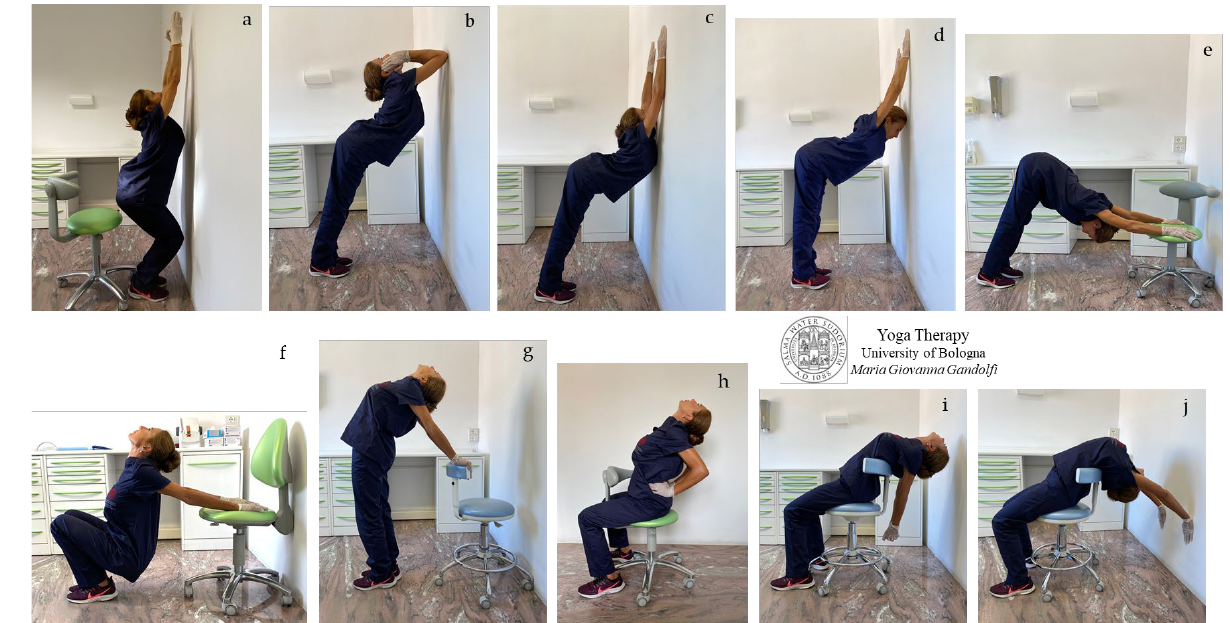
Figure 3. The figure displays the proposed āsana for neck and chest extension. Utkatāsana ( a ), Utthana/Sama Hasta Hanu Shishosana (standing puppy pose with hands on the chin) ( b ), Utthana/Sama Uttana Shishosana (standing extended puppy pose) ( c ), Utthana/Sama Adho Mukha Svanāsana (standing downward-facing dog) ( d ), Adho Mukha Svanāsana (downward-facing dog) ( e ), Upavistha Ardha Purvottanāsana (seated half-upward plank pose) ( f , i ), Anuvittāsana (variation of standing backbend pose) or Upavistha Sarpāsana or Salabhāsana (standing snake or locust pose) ( g ), Upavistha Anuvittāsana (seated backbend pose with palms pushing the sacrum) ( h ), and Upavistha Chakrāsana or Urdhva Dhanurāsana (seated full-wheel pose or upward bow pose) ( i , j ). It should be emphasized that the cervical muscles join and pull the cervical vertebrae together by approaching their origin in vertebral bone to their insertion in the overlying vertebra or in the occipital/temporal bone. The concept “muscles are bone ties” has been coined and developed by the yoga-expert author to explain visually (during her lectures on posturology and Yoga Therapy) that musculo-tendon structures are bonds/connections pulling together and nearing the bone segments where they are anchored. Among the eleven muscles connecting head–neck–upper back, rectus capitis (inferior nuchal line to C2), splenius capitis (temporal bone to C7-T3), semispinalis colli (T1–T6 to C2– C5), splenius capitis (ligamentum nuchae and C7-T3 to temporal bone), s plenius cervicis (lig- amentum nuchae and T3–T6 to C1–C3), and l ongissimus capitis (C4-T4 to temporal bone)